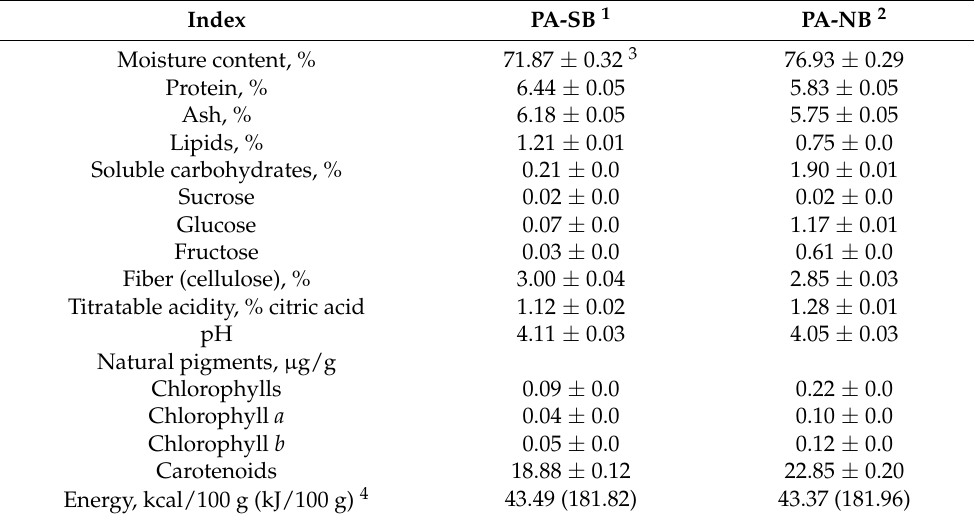
Table 2. Indices of the nutritional composition of Physalis alkekengi fruit (on a fresh weight